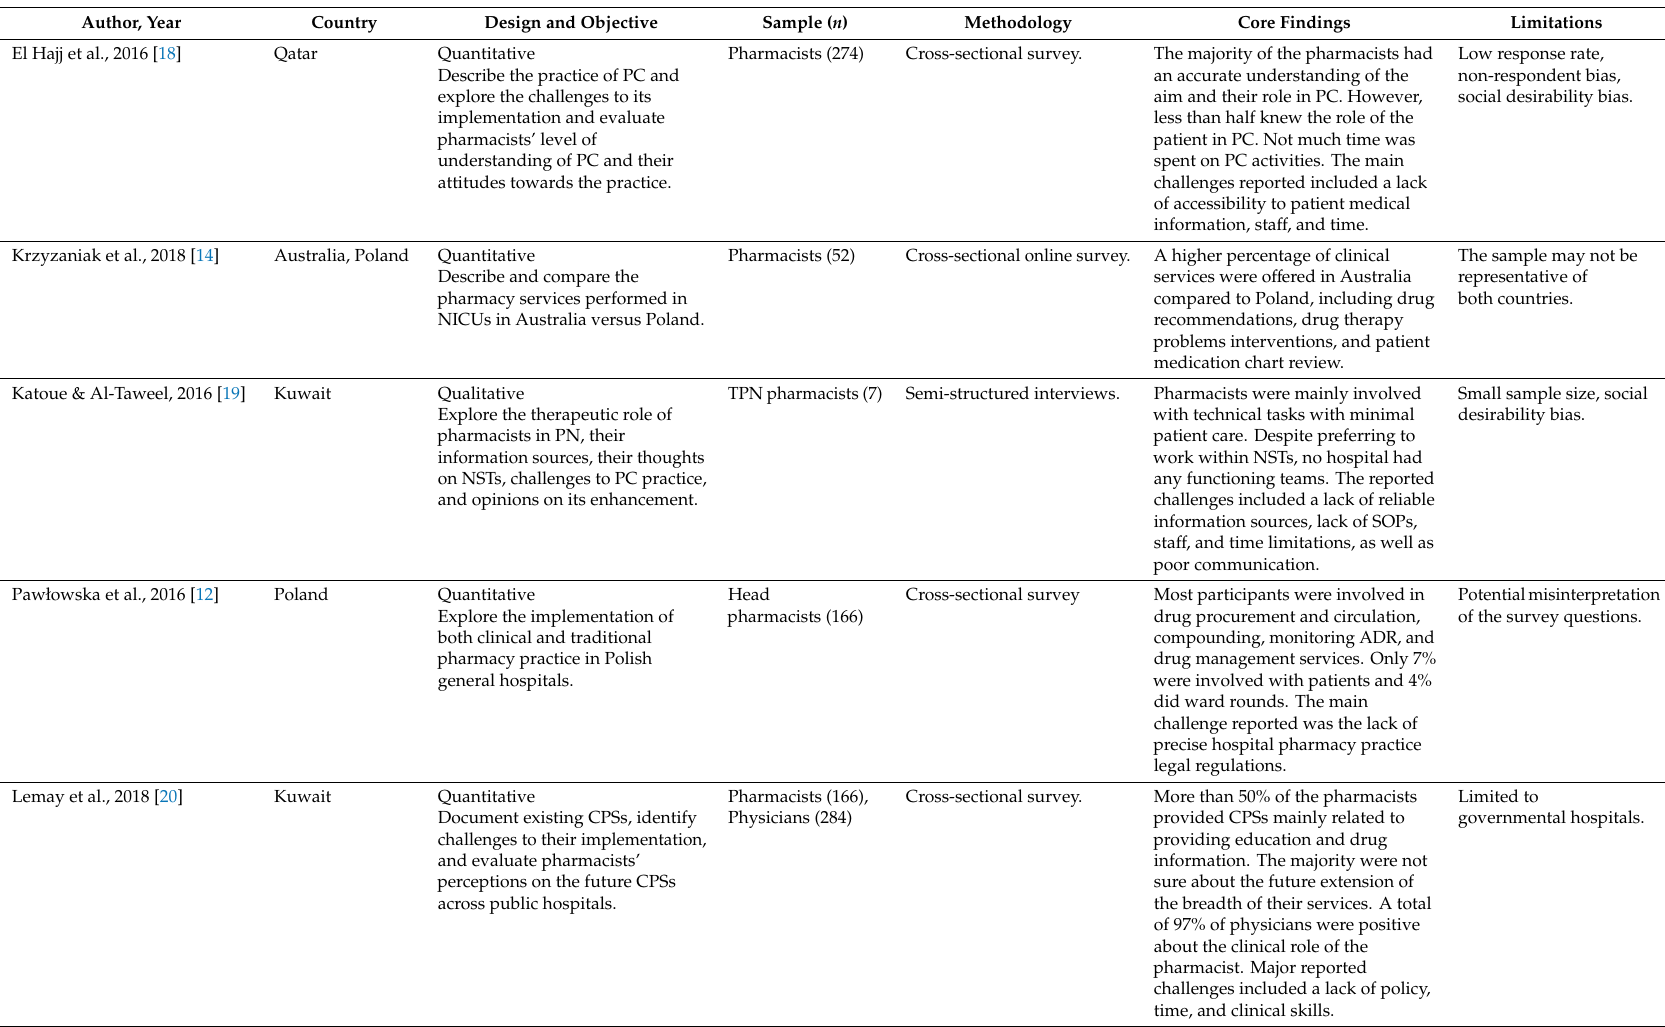
Table 1. Papers exploring hospital pharmacy